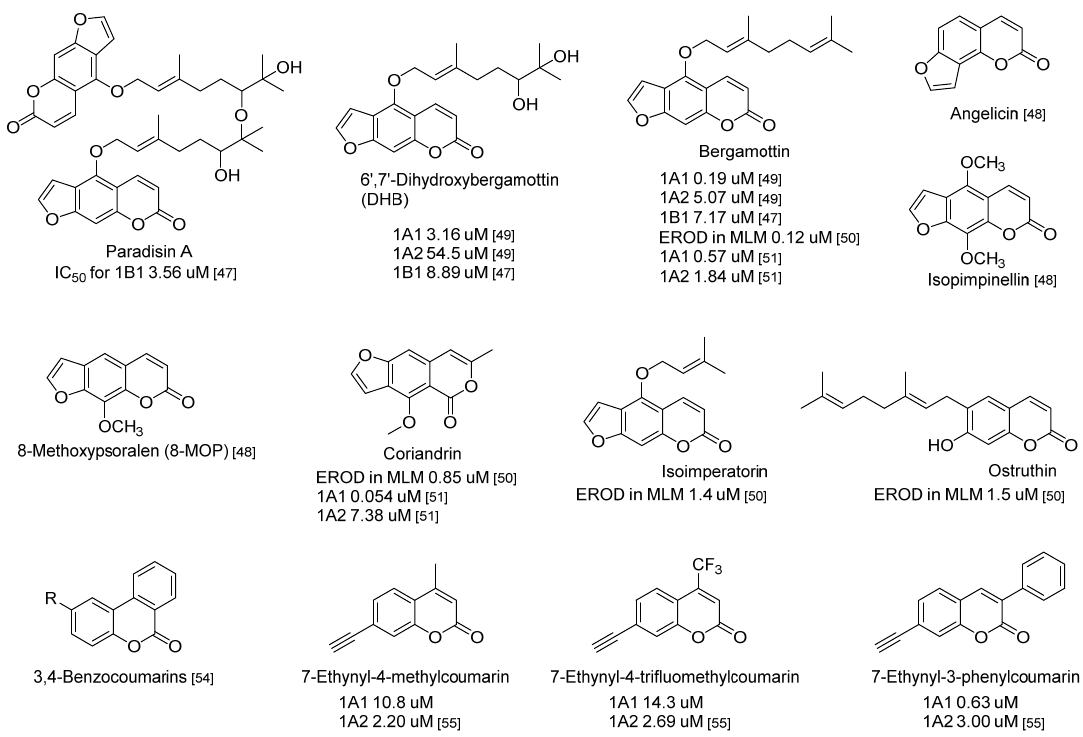
Figure 5. Coumarin derivatives as P450 family 1 inhibitors (MLM, mice liver